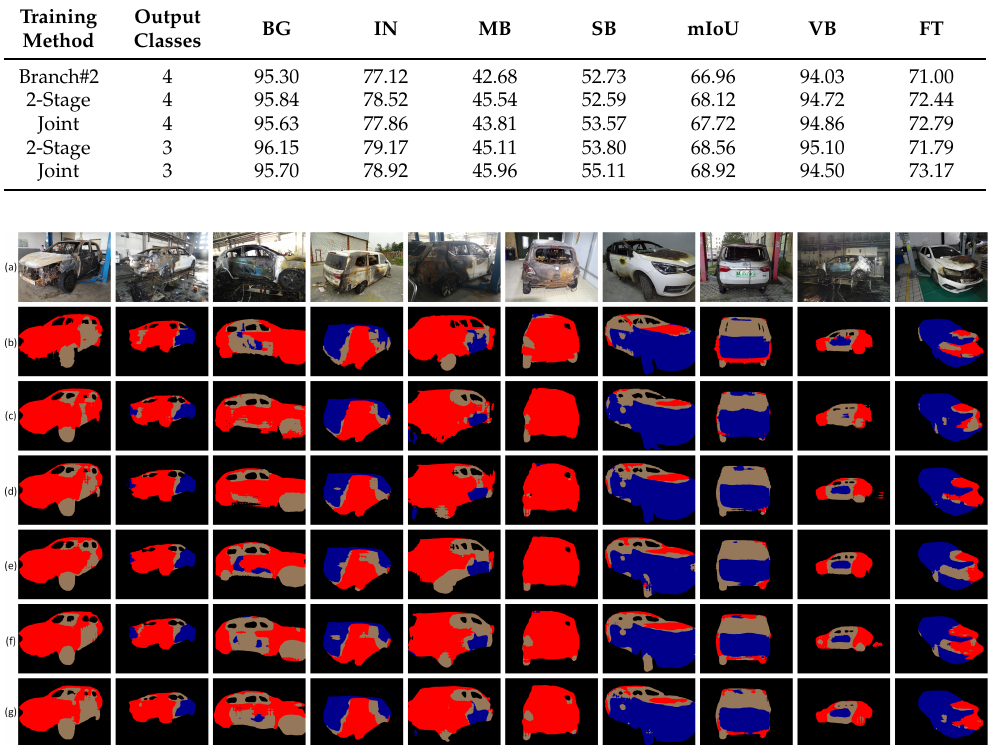
Figure 10. Results of the proposed DA-EMA in different training and output configurations. ( a ) Orig- inal images. ( b ) Labeled images. ( c ) Results of the single severity segmentation branch. ( d ) Results of the two-stage training and 4-class output. ( e ) Results of the joint training and 4-class output. ( f ) Re- sults of the two-stage training and 3-class output. ( g ) Results of the joint training and 3-class